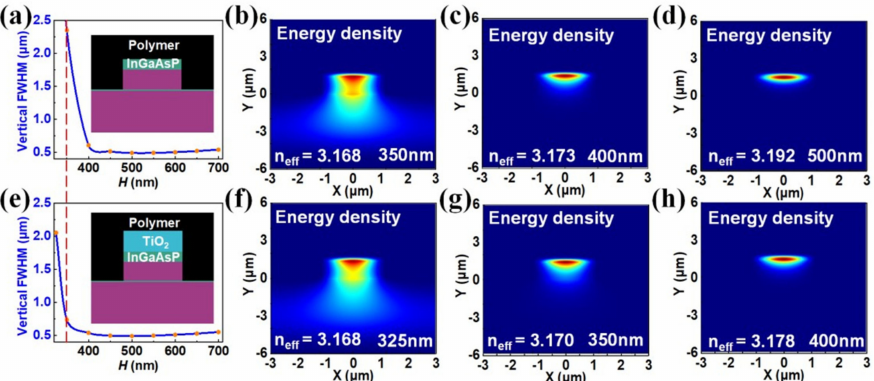
Figure 8. ( a ) Vertical FWHM mode size in the 4- µ m wide output region of the passive waveguide device as a function of the InGaAsP layer thickness with polymer ( n = 1.5) as the top cladding and InP as the bottom cladding. ( b ) The 2D mode intensity profile for a core thickness of 350 nm. ( c ) The 2D mode intensity profile for a core thickness of 400 nm. ( d ) The 2D mode intensity profile for a core thickness of 500 nm. ( e ) Vertical FWHM mode size in the 4- µ m wide output region of the passive waveguide device as a function of the InGaAsP layer thickness with TiO 2 ( n = 2.43) as the top cladding and InP as the bottom cladding. ( f ) The 2D mode intensity profile for a core thickness of 325 nm (for the TiO 2 case). ( g ) The 2D mode intensity profile for a core thickness of 350 nm (for the TiO 2 case). ( h ) The 2D mode intensity profile for a core thickness of 400 nm (for the TiO 2